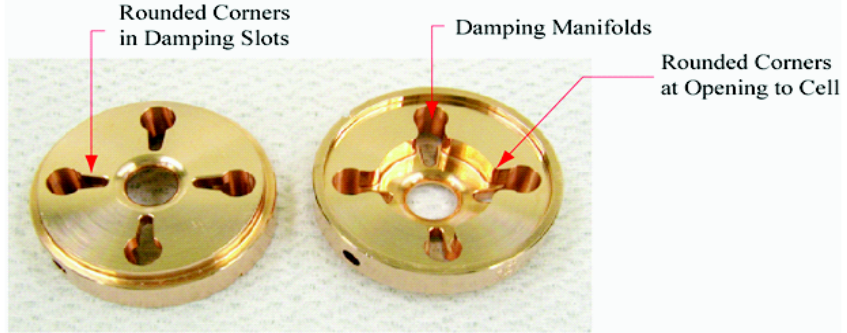
FIG. 7. (Color) Two completed cells for the accelerating structures H60VG4SL17A/B. The inner iris region, where the beam traverses, is surrounded by four manifolds. The tapered coupling slots are clearly displayed in the left-hand photograph.